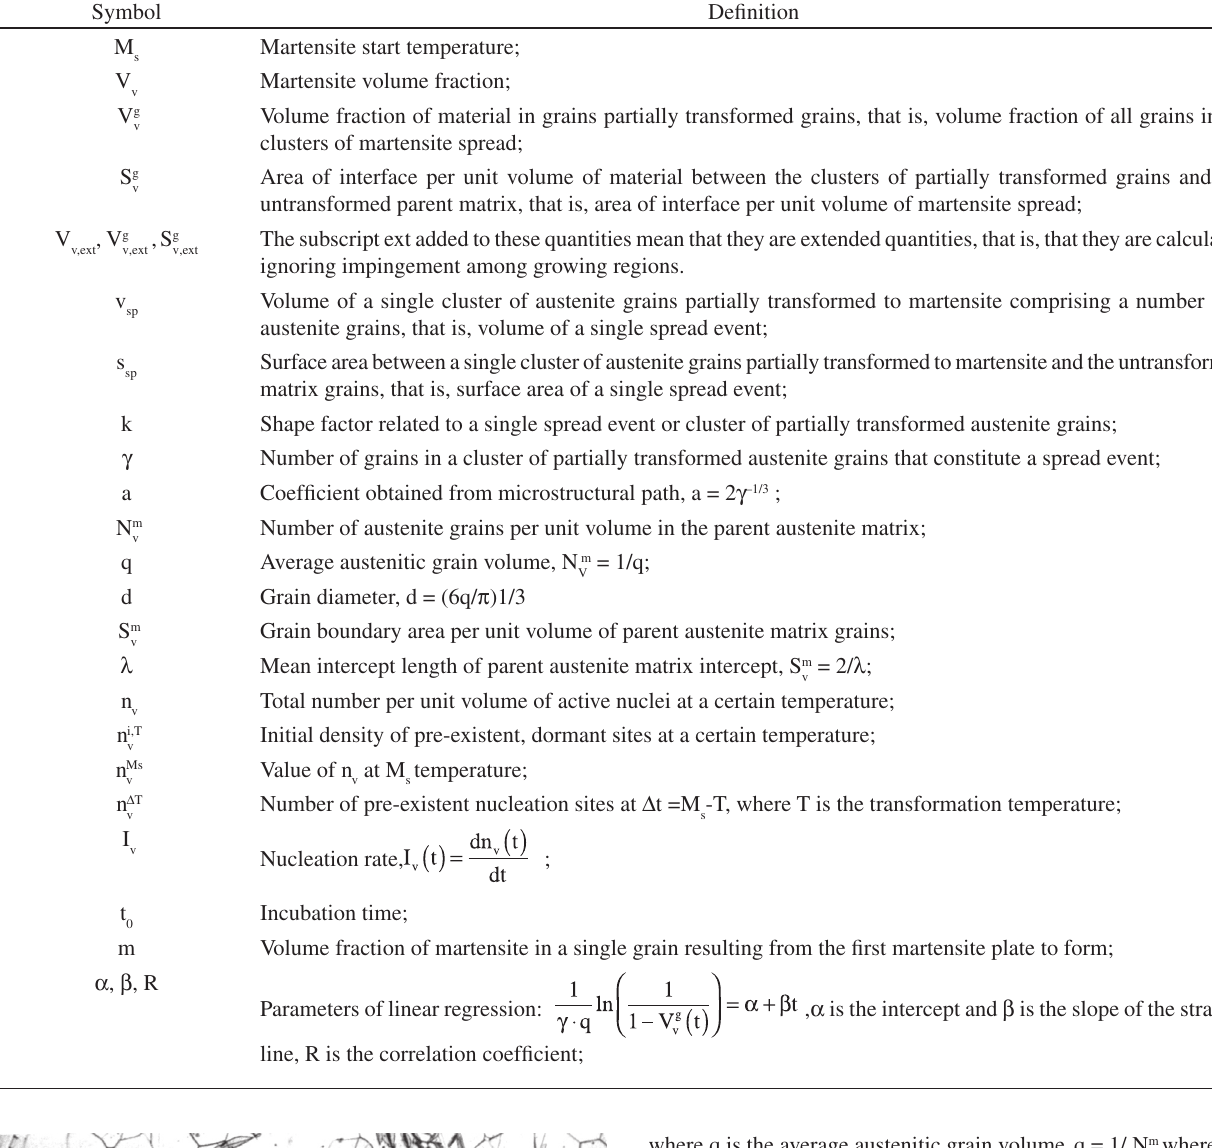
Table 1. List of symbols used in this paper and their definitions.